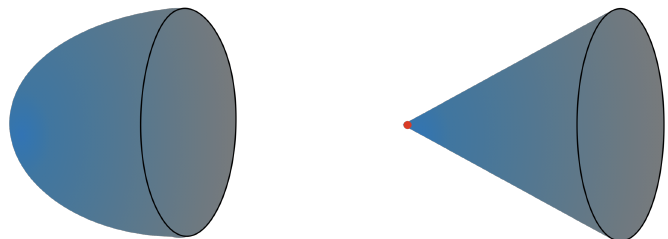
Figure 4 . The conical defect: on the left is EAdS 2 . An insertion of the defect operator D ( z ) at the origin z = 0 creates a conical singularity and the resulting geometry is EAdS 2 with a deficit